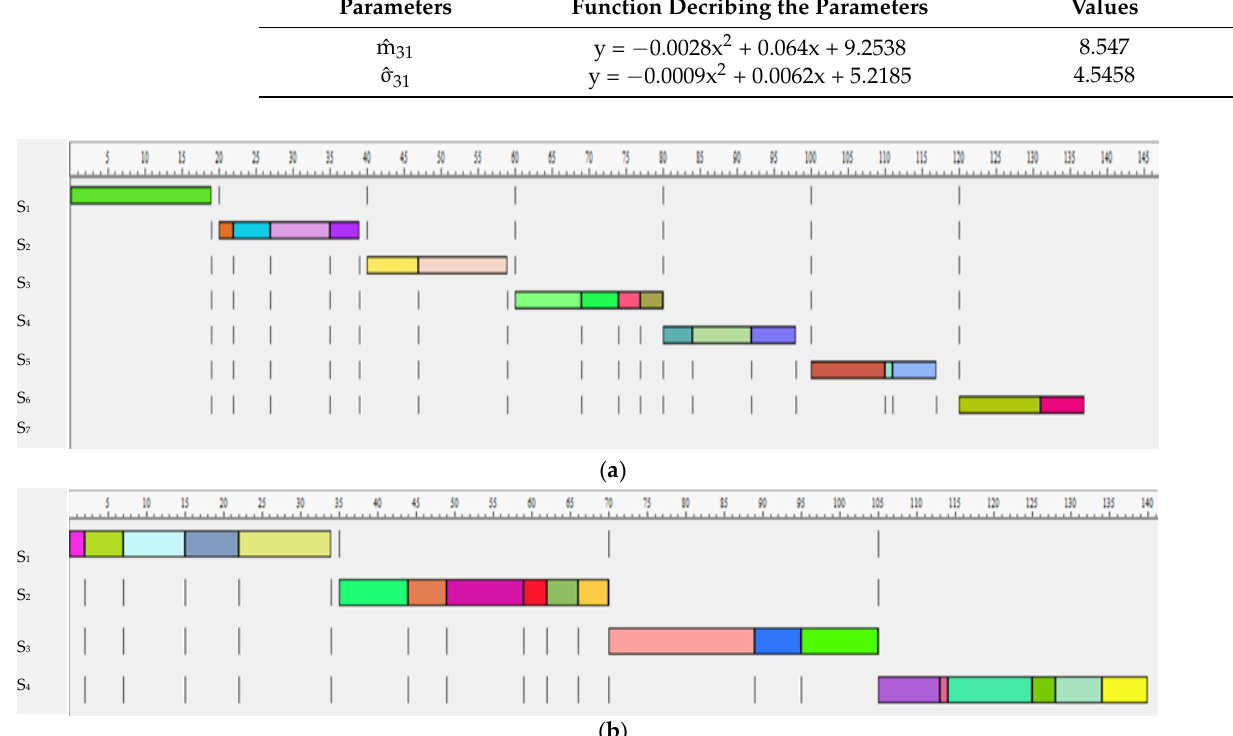
Figure 6. Disassembly tasks assigned to stations according to the decreasing demand and: ( a ) cycle time equals 20 min; ( b ) cycle time equals 35 min.